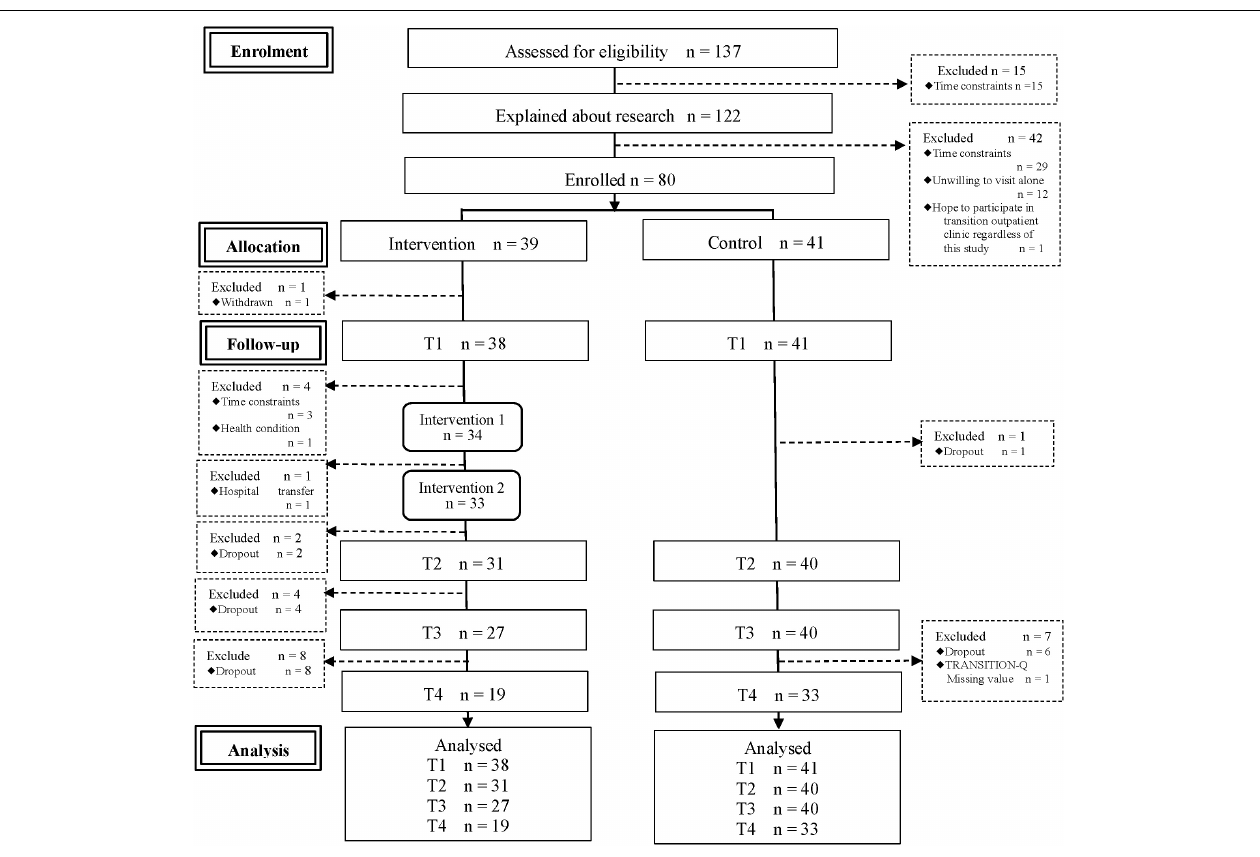
FIGURE 1 | Flow diagram of the progress through the phases of a parallel randomized trial of two